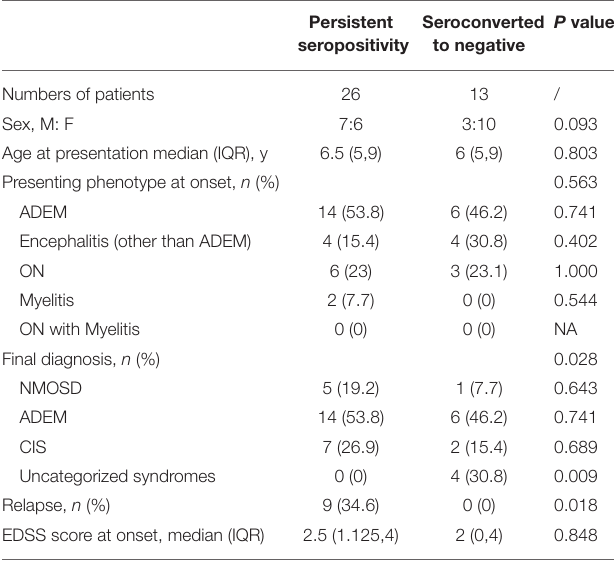
TABLE 6 | Comparison of demographic and clinical features of children with MOG-ab persistently seropositive and seroconverted to negative.